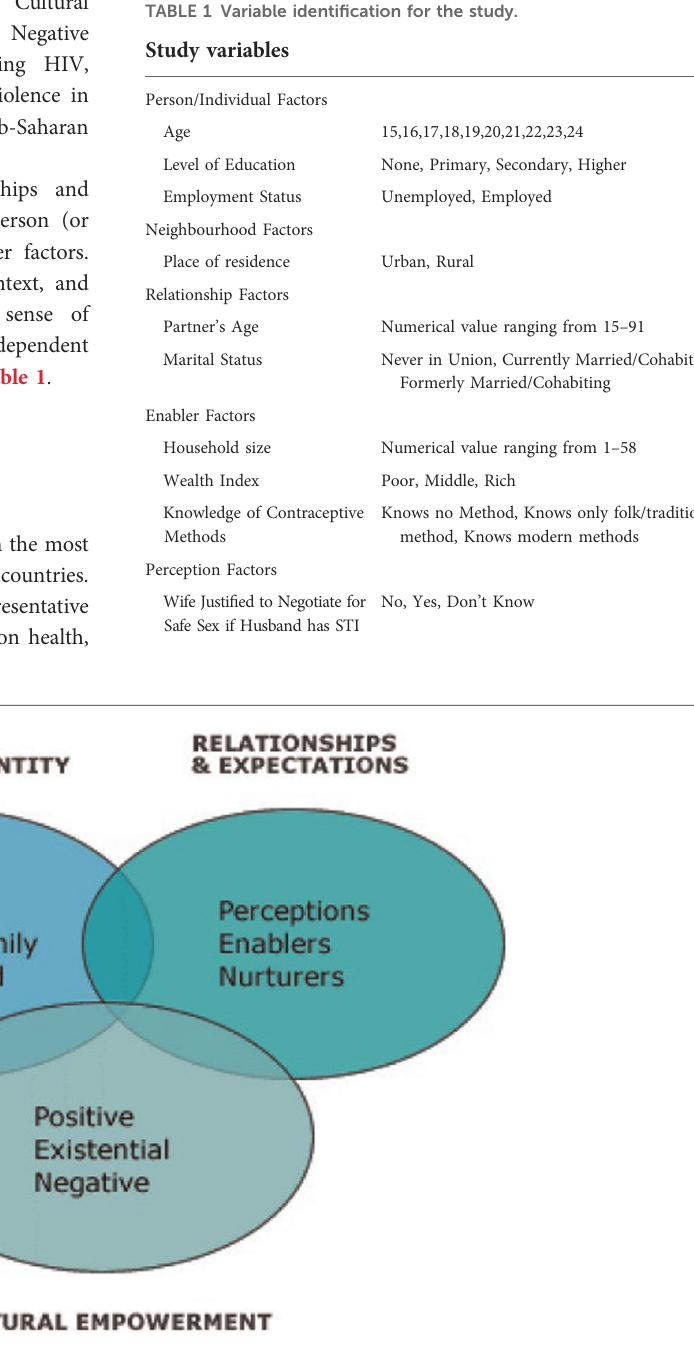
FIGURE 1 The PEN-3 cultural model from Blackstone, Nwaozuru and Iwelunmor (2018).